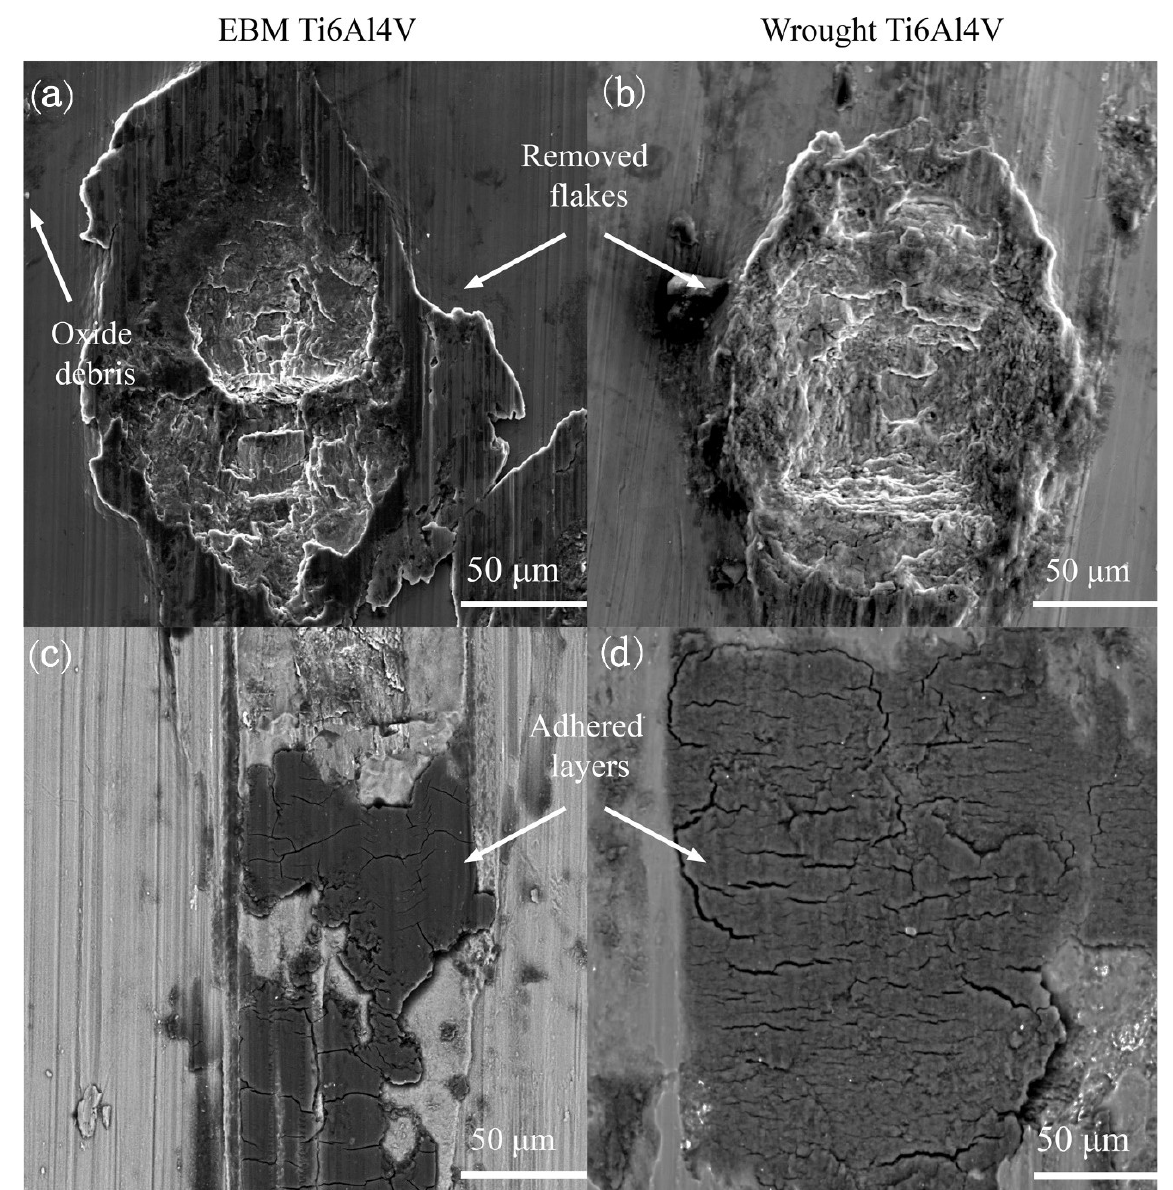
Figure 13. Main wear mechanisms for the EBM and wrought Ti-6Al-4V parts: ( a , b ) abrasive wear and ( c , d ) adhesive wear [130] (Reprinted with permission from [130]. Copyright 2016, Elsevier).